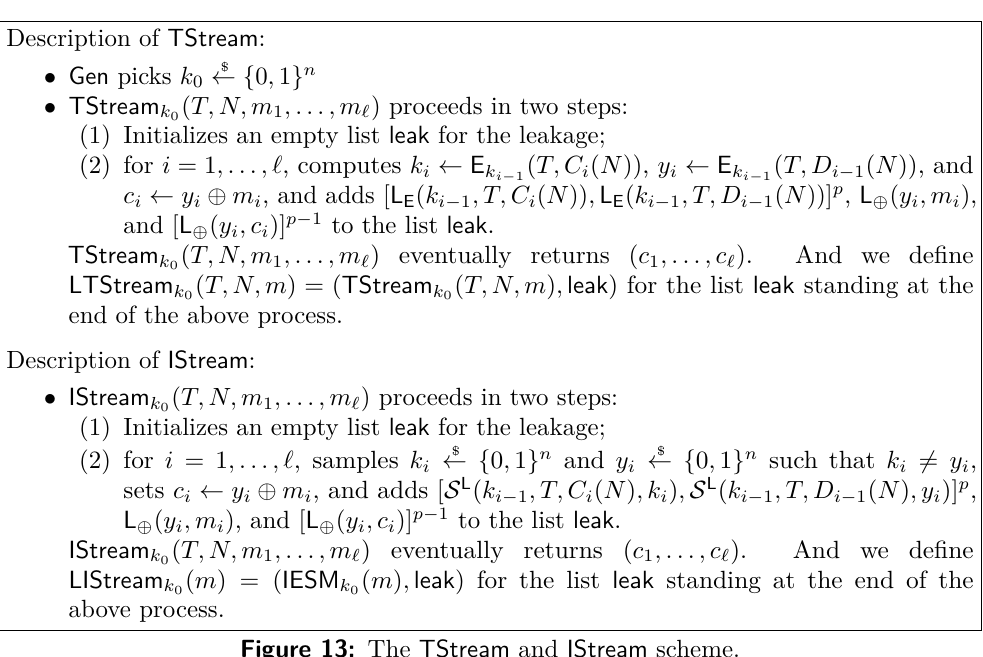
Figure 13: The TStream and IStream